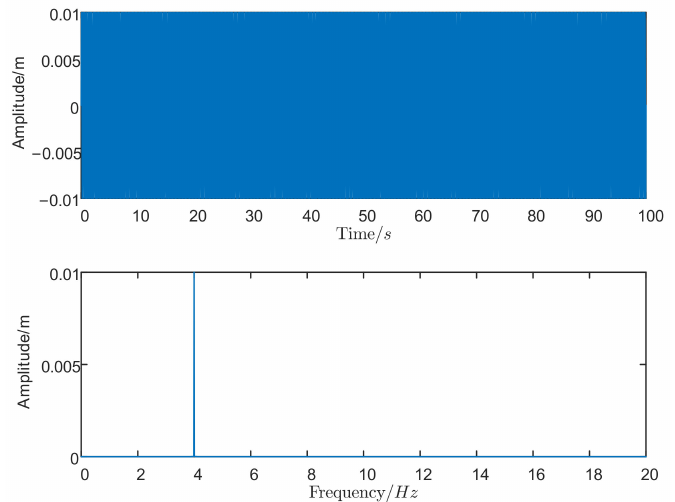
Figure 16. Time histories and FFT result of displacement excitation at f = 4 Hz.